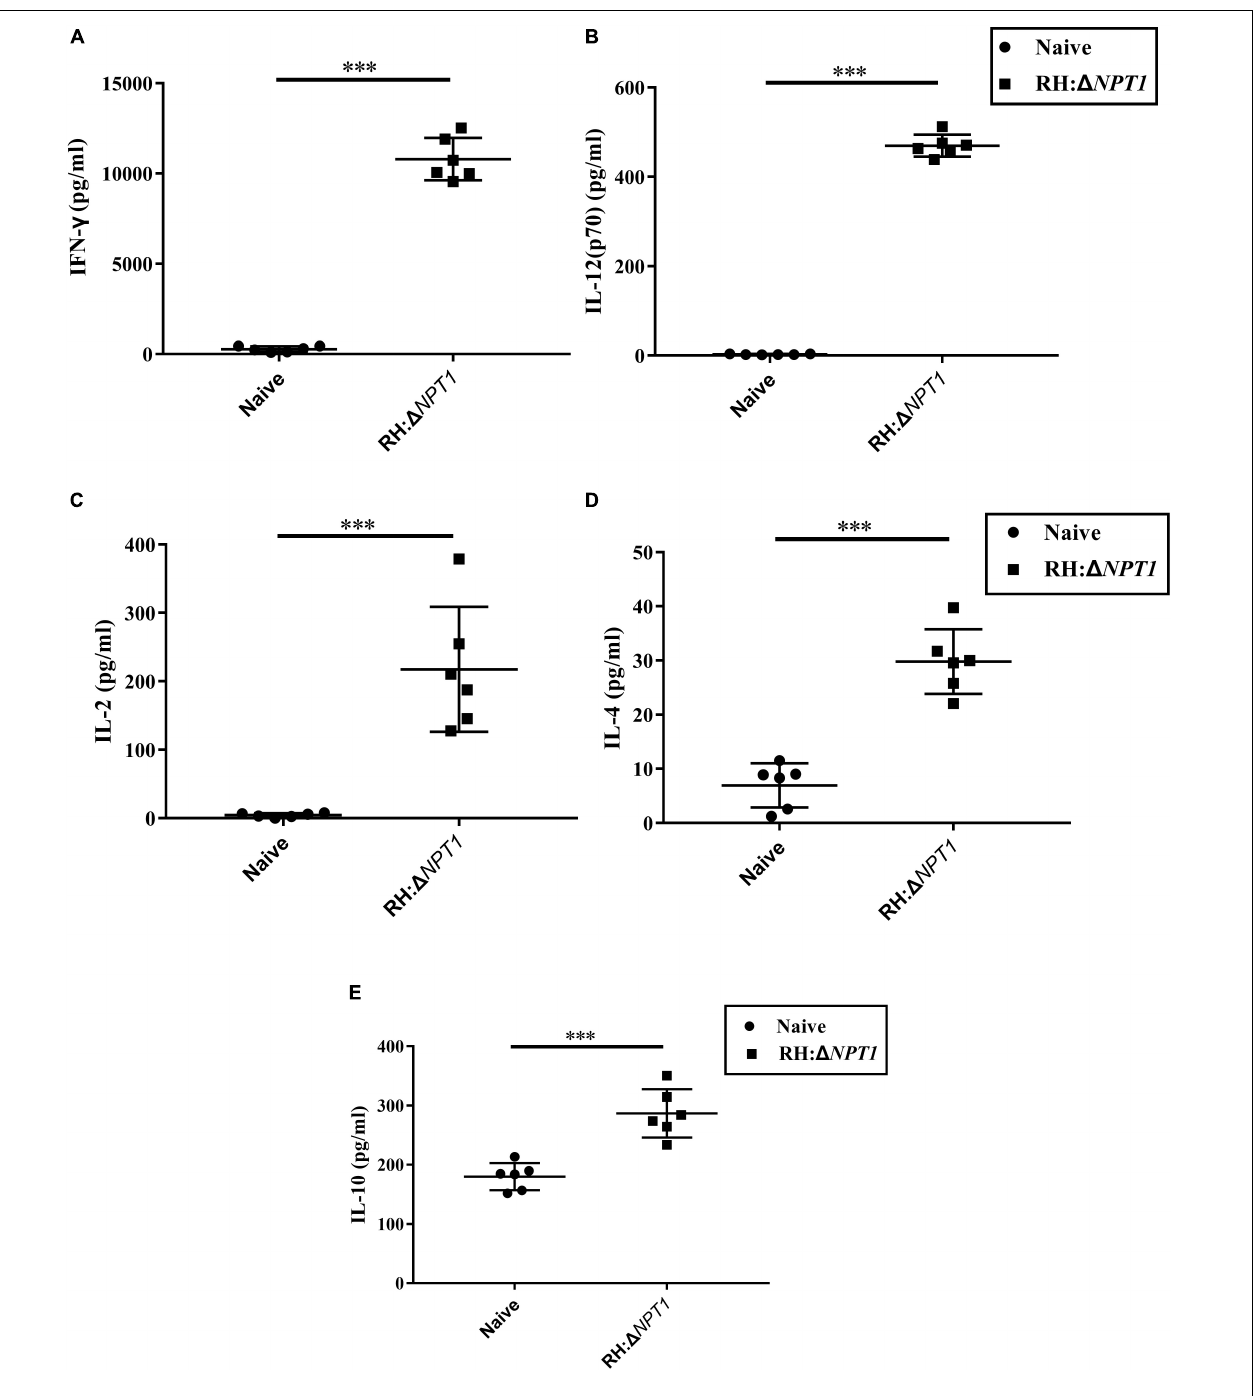
FIGURE 4 | The levels of cytokines in the splenocyte suspension of mice immunized with RH: (cid:49) NPT1 . Splenocytes collected from the immunized and non-immunized mice (42 days post-vaccination) were co-incubated with STAg (10 µ g/ml). Subsequently the levels of Th1 [IFN- γ (A) , IL-12 (B) , and IL-2 (C) ] and Th2 [IL-4 (D) and IL-10 (E) ] in the culture supernatants were analyzed by ELISA. The high levels of cytokines produced by splenocytes culture of immunized mice were significantly higher than naive mice. The results are presented as the mean of OD450 ± SD ( n = 6; ∗∗∗ P < 0.001; n.s. , not significant;